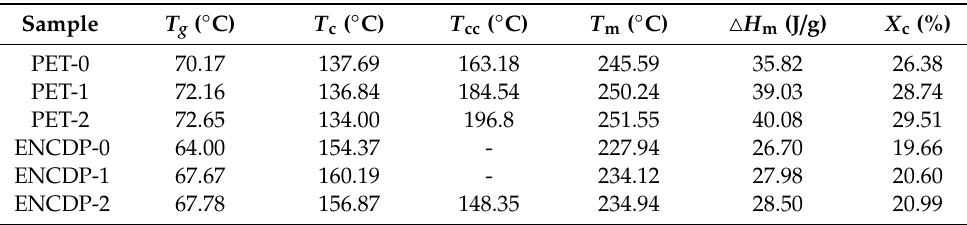
Table 7. The thermal parameters of